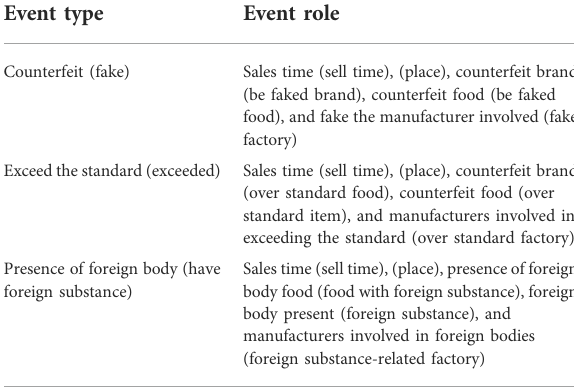
TABLE 1 Pre-de fi ned event schema of FD-OR. Event type Event